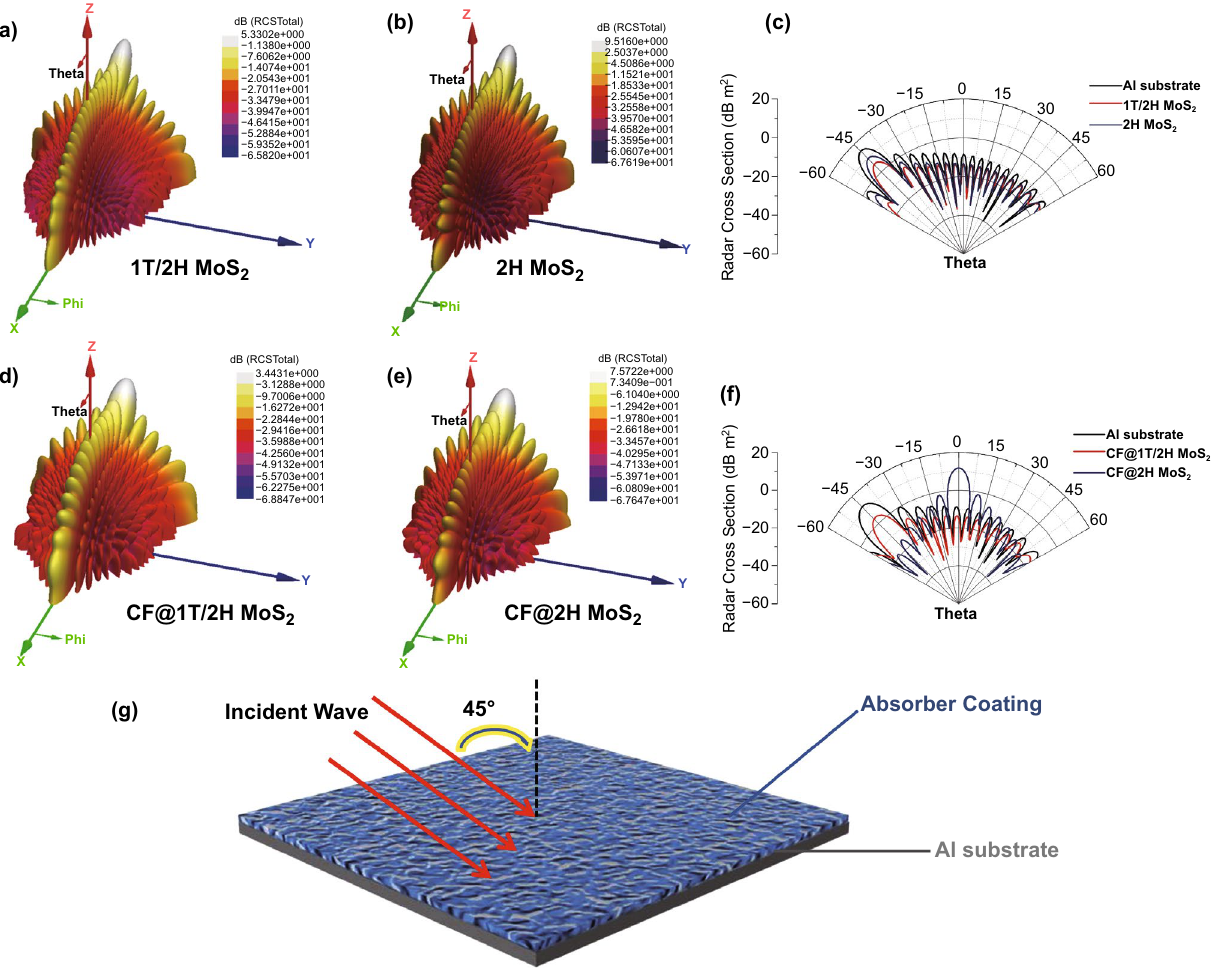
Fig. 9 a , b , d , e Three-dimensional spherical coordinate diagrams. c , f Polar coordinate diagram. g Schematic diagram of HFSS simulation